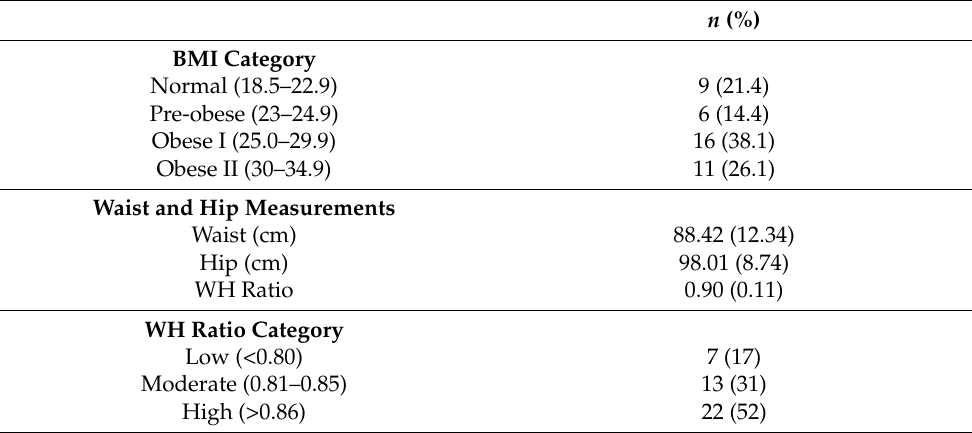
Table 2. Anthropomorphic characteristics ( n = 42).